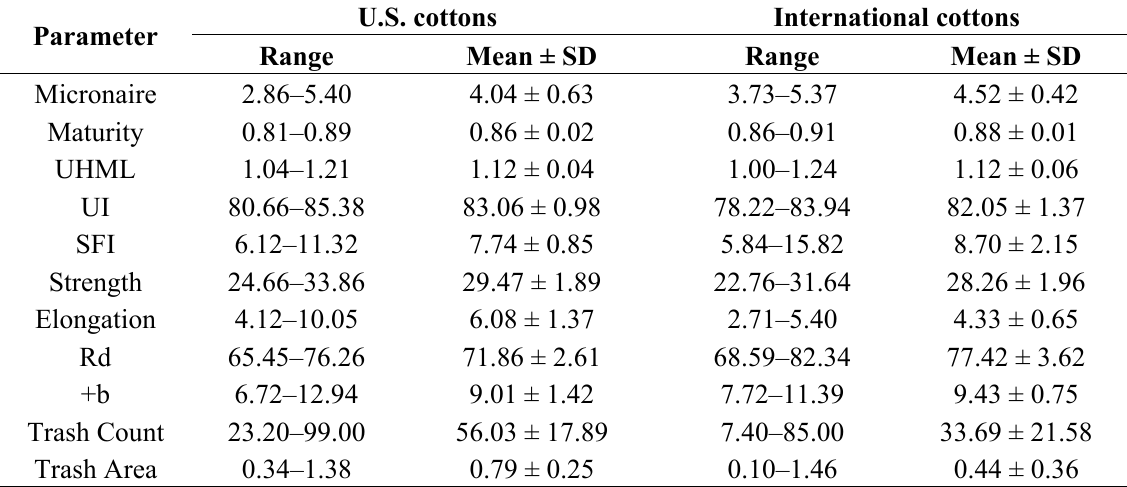
Table 2. High Volume Instrument (HVI) data for U.S. and international cottons. UHML, the upper half mean length; UI, uniformity index; SFI, short fiber index; Rb, brightness value; +b, yellowness